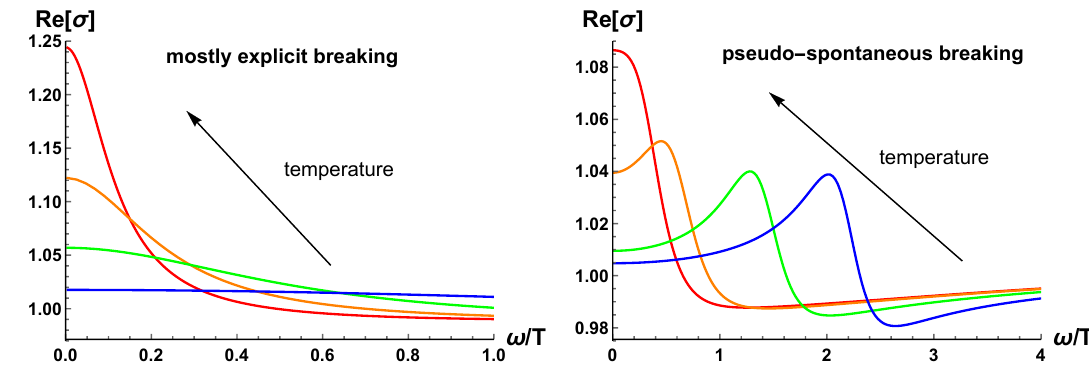
Figure 8 . AC conductivity moving the dimensionless temperature parameter at (cid:12)xed chemical potential (cid:22)=T = 0 : 5. Left: a mostly explicit case (cid:12) = 0 : 1. The behaviour is a coherent-incoherent crossover. Right: a mostly spontaneous case (cid:12) = 10. Now the behaviour is from a Drude peak to a coherent pinned